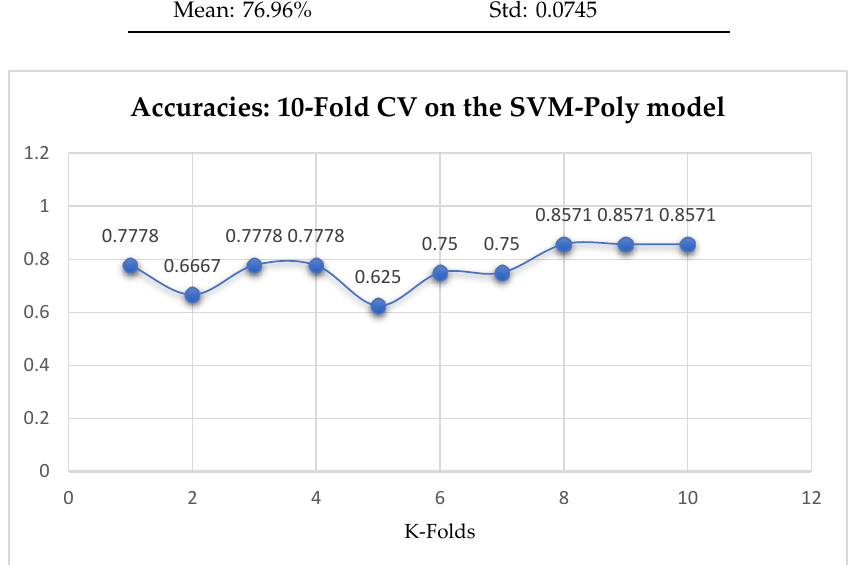
Figure 31. The accuracies achieved by the Folds after performing 10-Fold Cross-Validation on the SVM-Poly model.